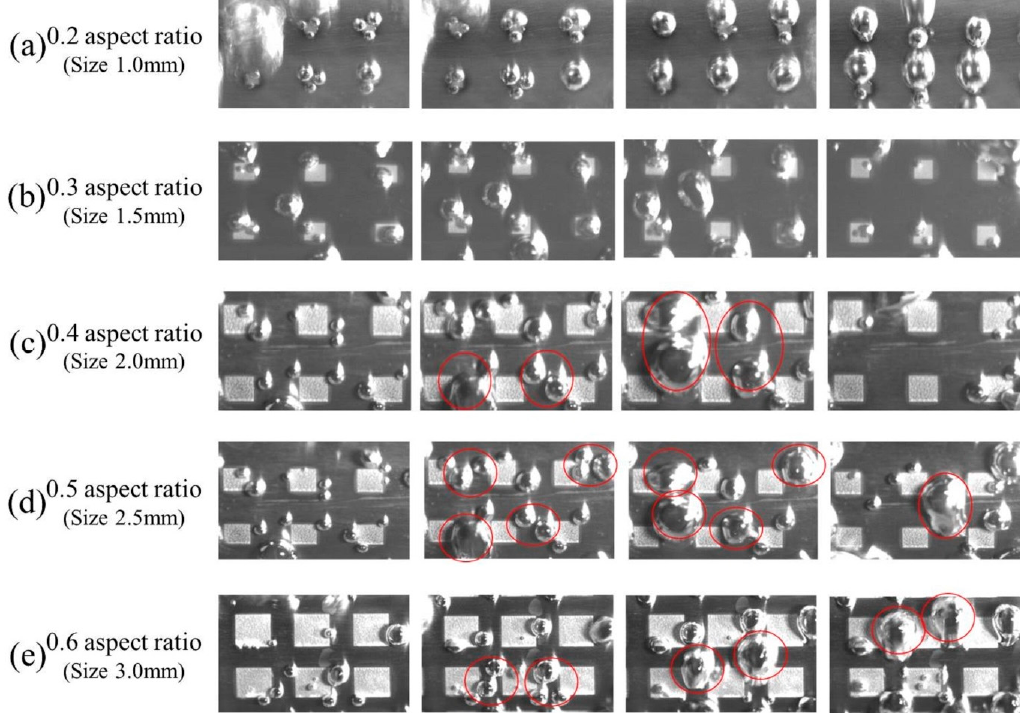
Figure 10. Bubble development mechanisms of the surfaces with ( a ) 0.2 aspect ratio; ( b ) 0.3 aspect ratio; ( c ) 0.4 aspect ratio; ( d ) 0.5 aspect ratio; and ( e ) 0.6 aspect ratio. ( c ) 0.4 aspect ratio; ( d ) 0.5 aspect ratio; and ( e ) 0.6 aspect